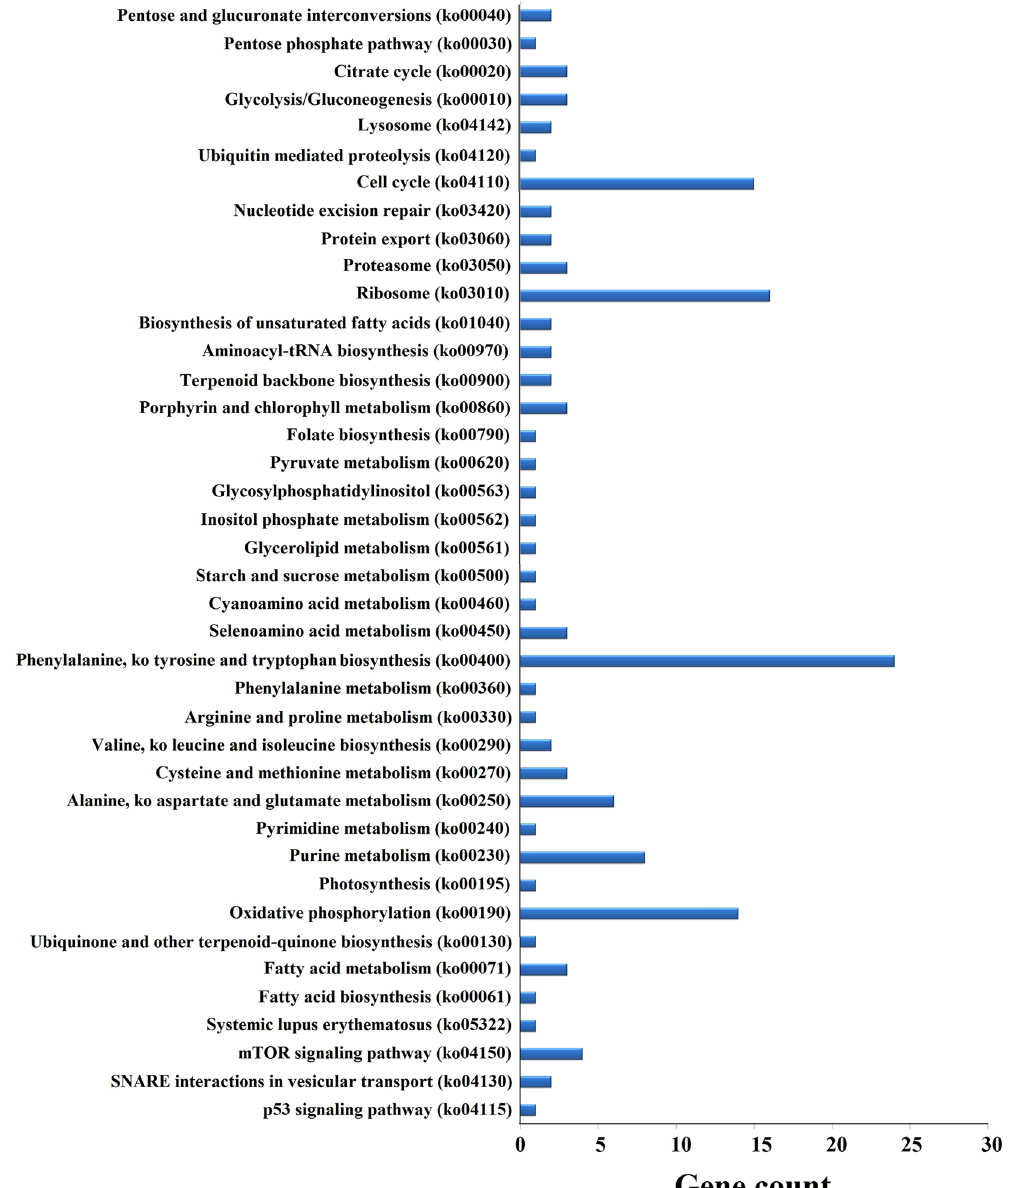
Figure 7. KEGG pathway analysis of the predicted potential targets of differentially expressed miRNAs in Camellia sinensis